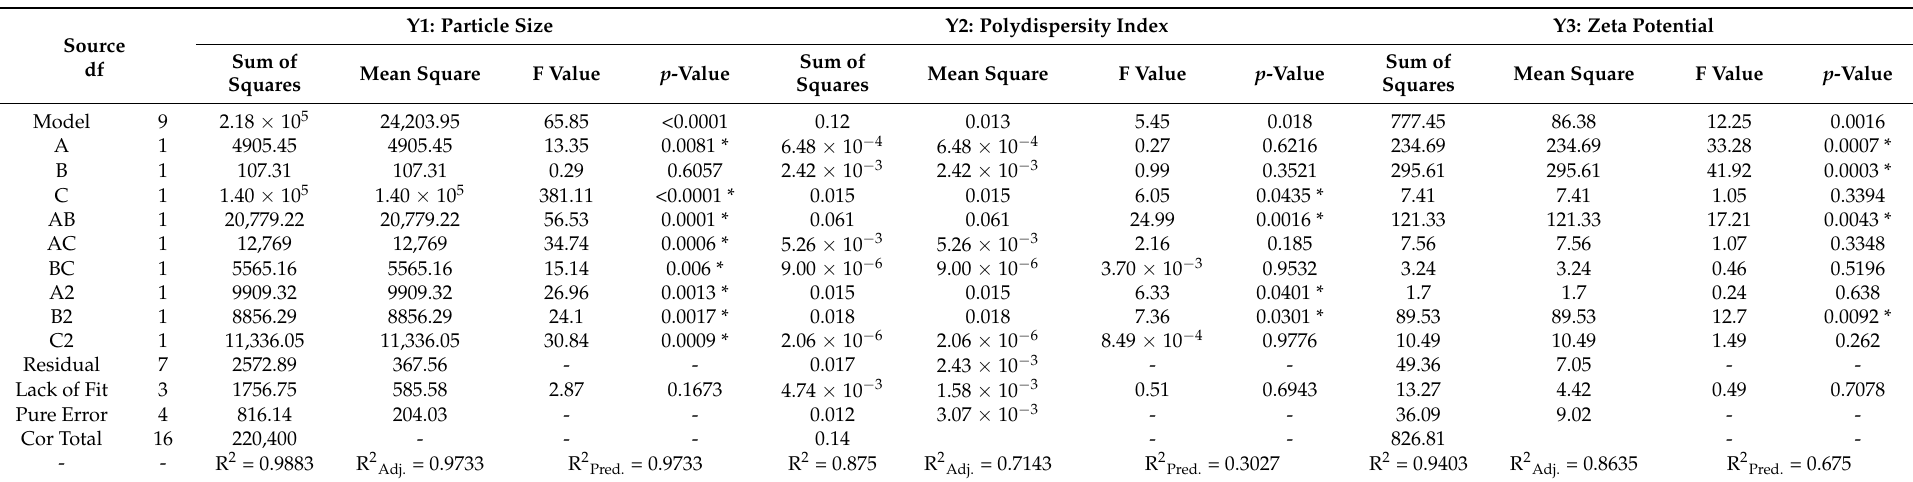
Table 4. Output data of the Box–Behnken design analysis of